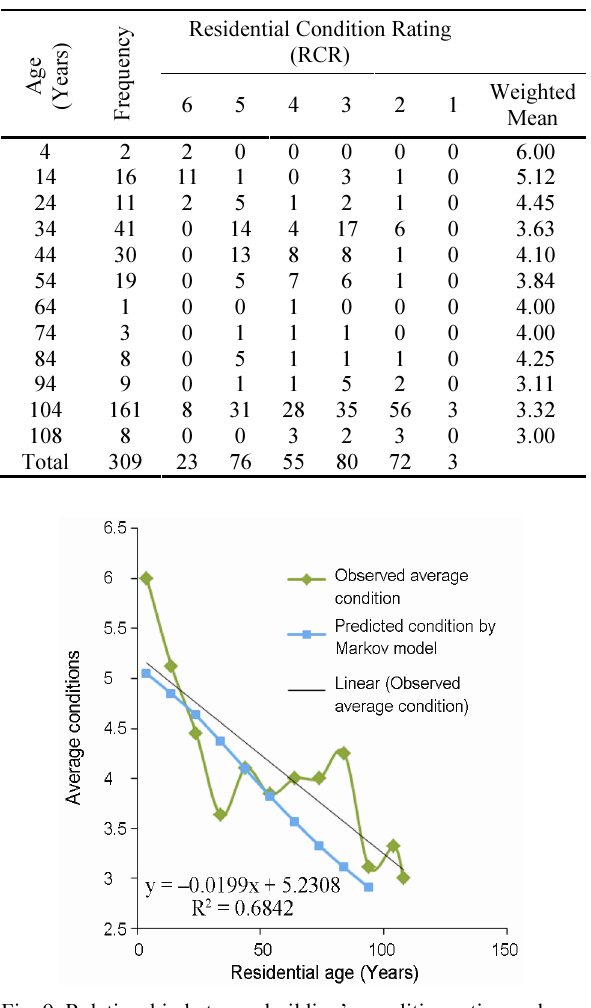
Fig. 9. Relationship between building’s condition rating and